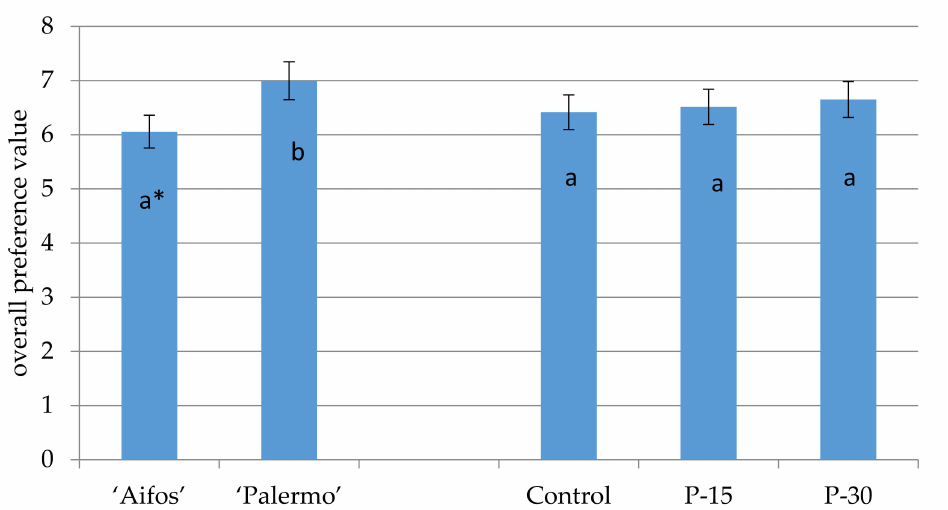
Figure 8. Overall sensory preference for pepper fruits as a ff ected by cultivar and fertilized with polyphosphates in hydroponic cultivation (average of two terms). * The bars marked with the same letters do not di ff er significantly according to the Tukey HSD test at α =